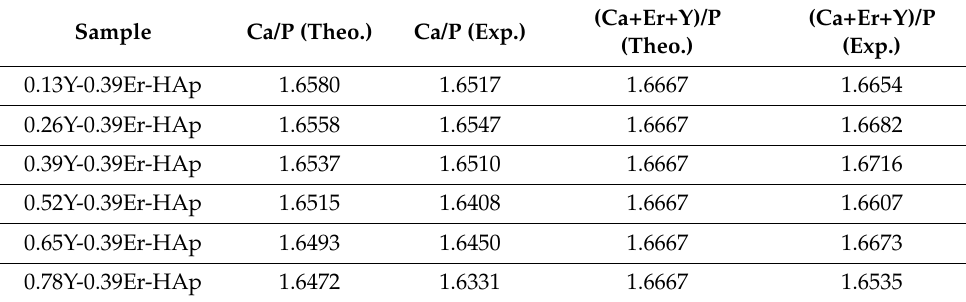
Figure 5. SEM images and EDX analysis. Table 4. Theoretical and experimental values of the Ca/P and (Ca+Er+Y)/P ratios.